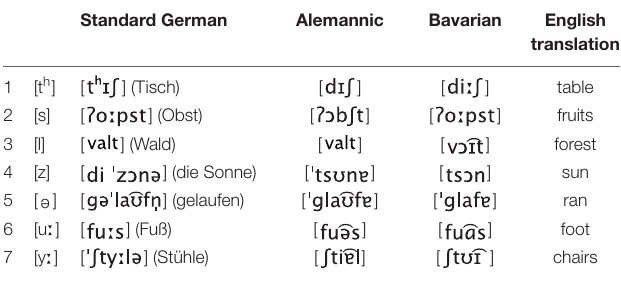
TABLE 1 | Example of differences between Standard German, Alemannic, and Middle